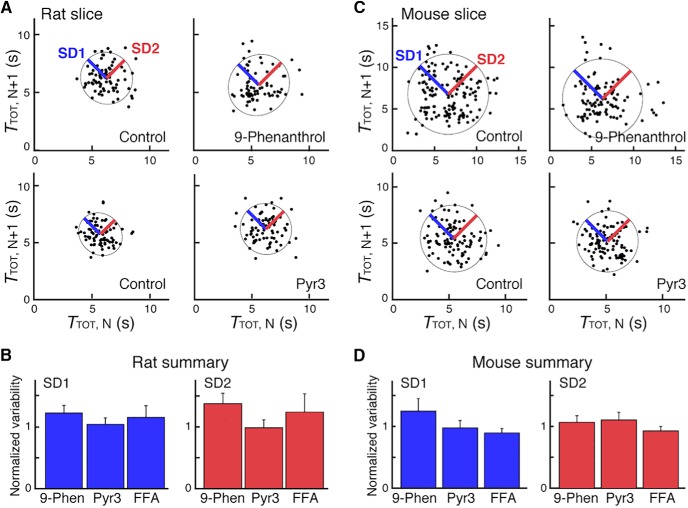
Pharmacological inhibition of TRPM4, TRPC3, and ICAN does not affect variability of inspiratory rhythm in vitro. A, B, Poincaré maps (A) from a representative in vitro rat slice experiment with inhibition of TRPM4 and TRPC3 channels, respectively, by 9-phenanthrol (9-Phen in B) and Pyr3, illustrating geometric fits of XII inspiratory period data and representations of short-term (SD1) and long-term (SD2) variability measures (see Methods for definitions), and summary data (B) for the analyzed group (n = 6 each). C, D, Equivalent sets of data from in vitro mouse slice experiments. Variability measures normalized to control values were not statistically significant in all cases in B and D. TTOT, respiratory period.